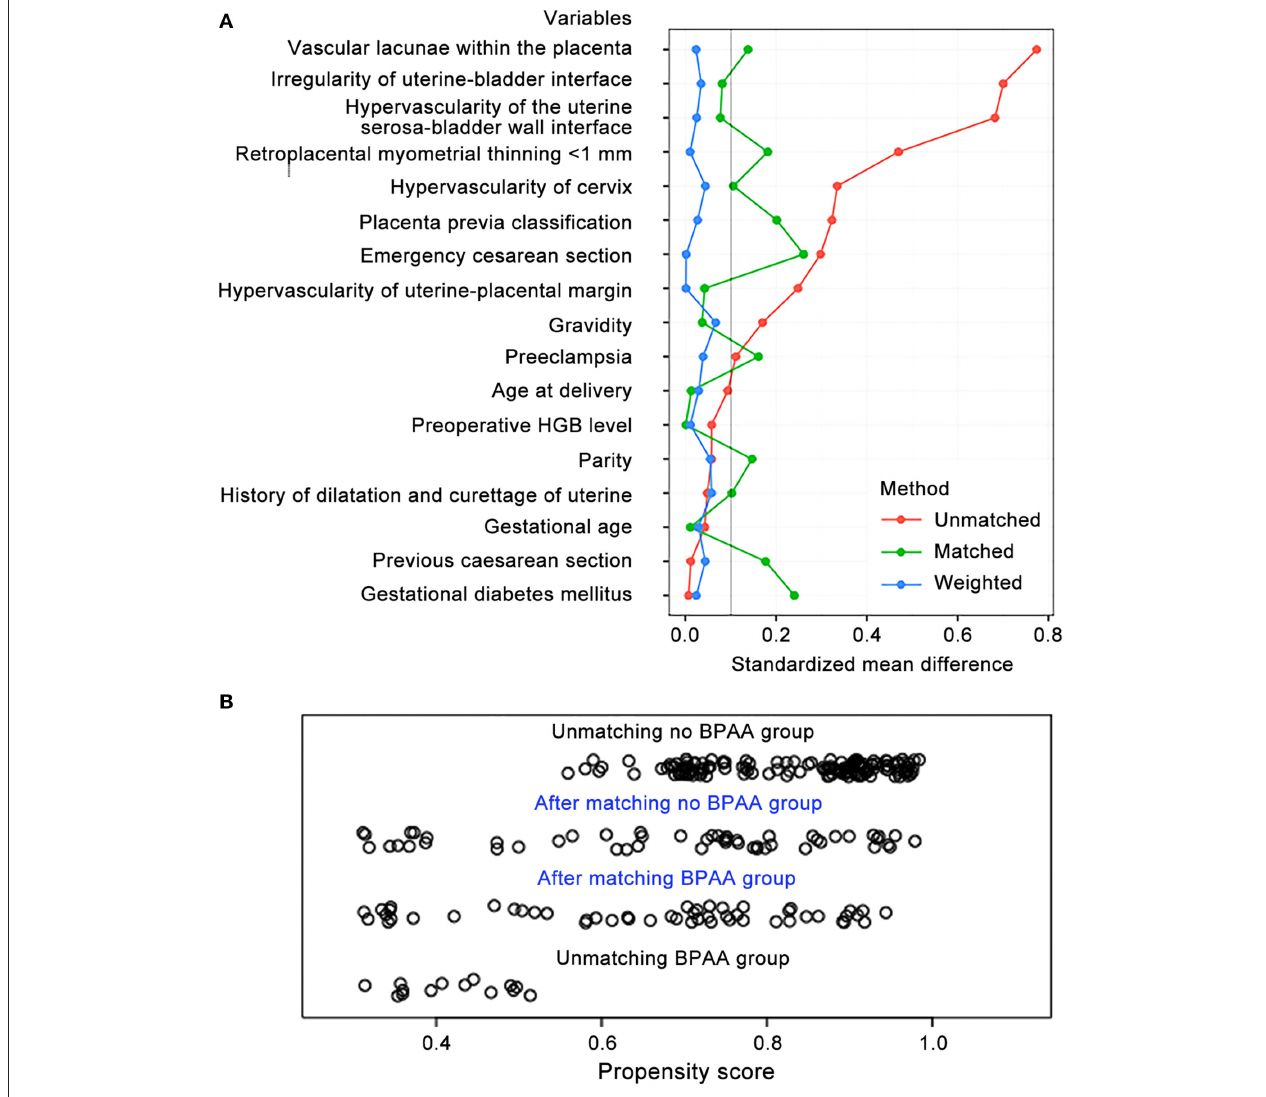
FIGURE 3 | Propensity score matching of variables. (A) The standardized mean differences in variables between the non-BPAA and BPAA groups. (B) The distribution of the propensity scores before and after score-matching analysis. BPAA, balloon placement in the abdominal aorta; HGB, hemoglobin.